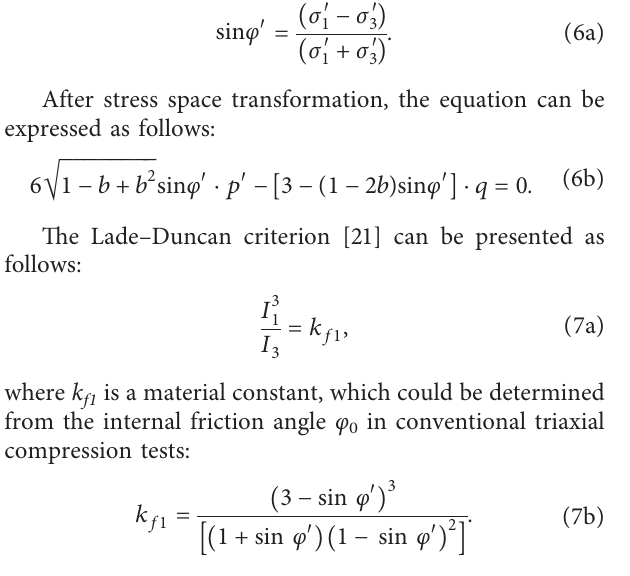
Figure 12: Summary of peak states in different true triaxial tests.